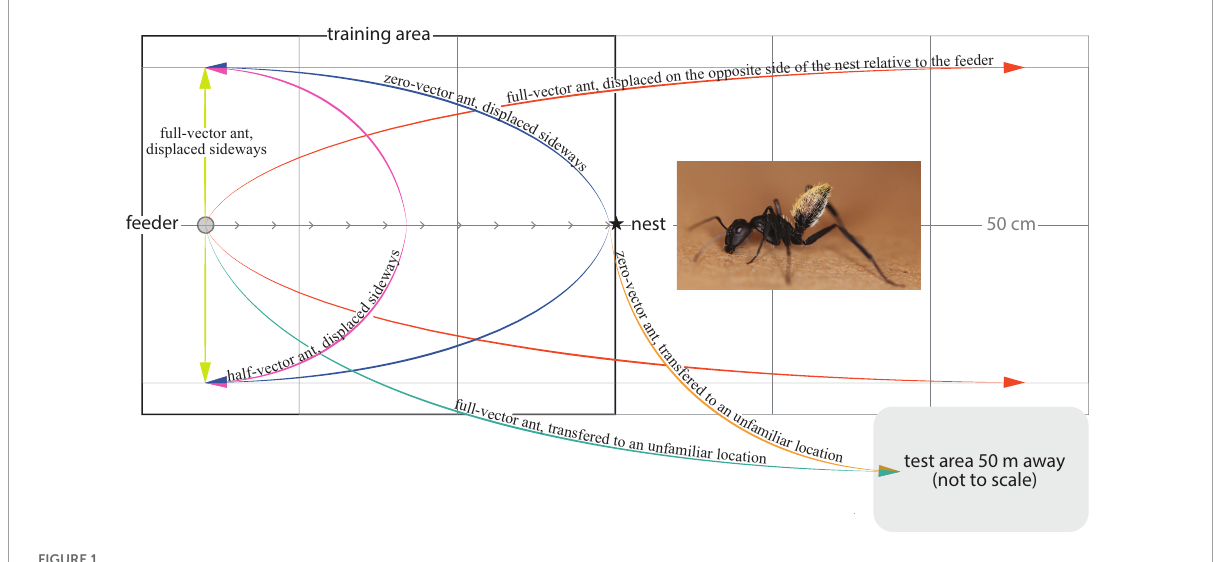
FIGURE1 The balbyter ant Camponotus fulvopilosus and experimental treatments. The ants were trained to forage on a sucrose solution at a feeder (gray circle), 125 cm away from the nest (star) (Gray arrows, direct path home). Once trained, the ants located the feeder and started to drink from it, were either caught there (full-vector ants, green and yellow), or allowed to fill their gaster and return toward their nest. These ants were then either caught 0.62 m along their path (half-vector ants, pink) or just before they entered their nest (zero-vector ants, blue or orange). Captured ants were then transferred to an unfamiliar test area 50 m away (green), or displaced to a position 50 cm to either side of the feeder (yellow) or to the corresponding position 125 cm on the opposite side of the nest relative to the feeder